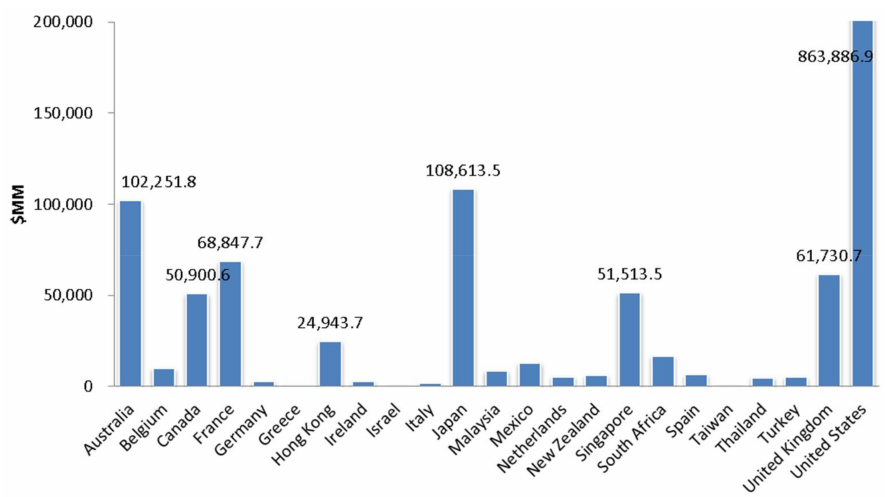
Figure 1. Market capitalization of the S&P Global REIT (Real Estate Investment Trust) Index in August 2016. Data Source : S&P Capital